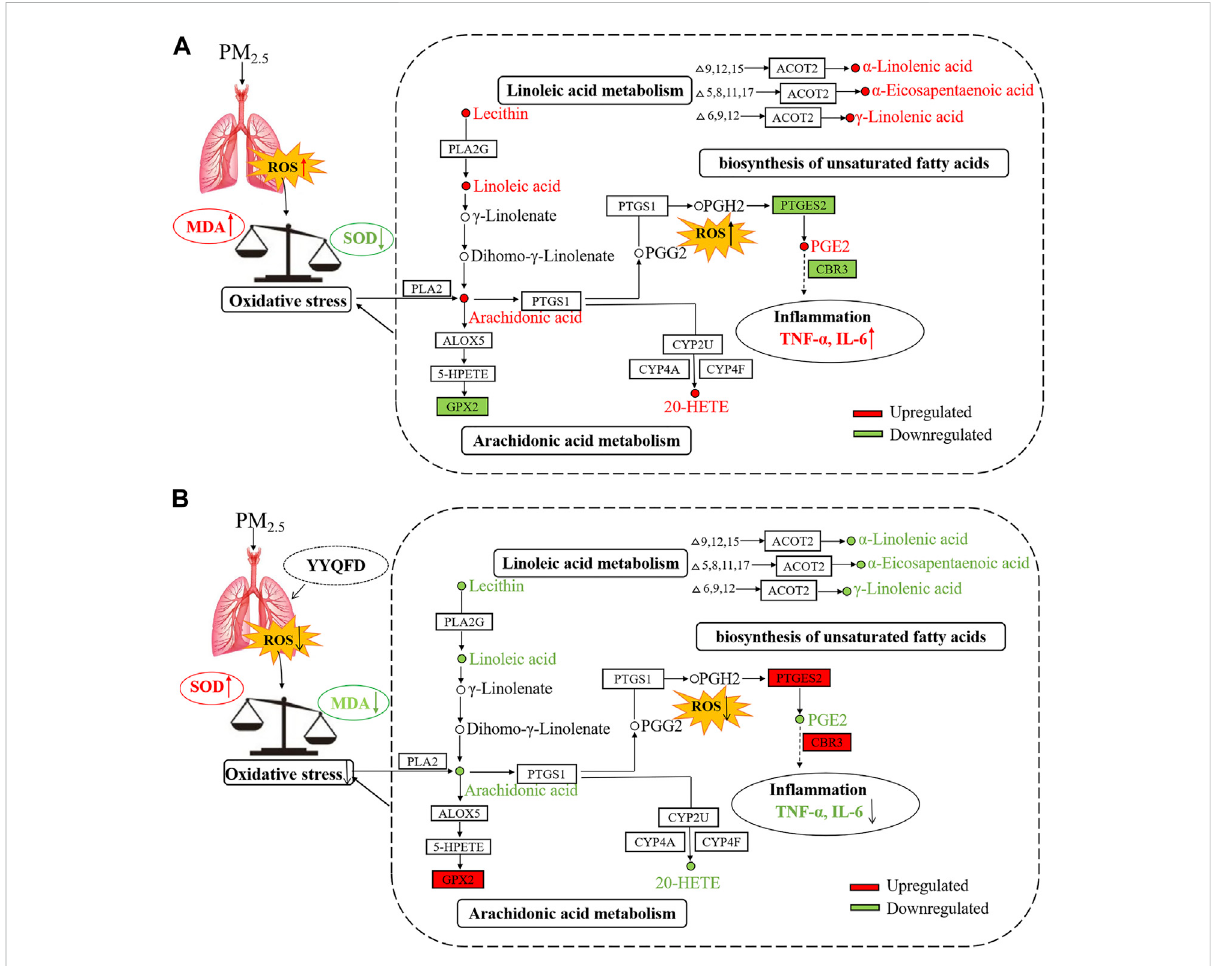
FIGURE 8 The mechanism diagram of the lung injury in mice caused by PM 2.5 (A) and YYQFD repairing the lung injury in mice caused by PM 2.5 (B)